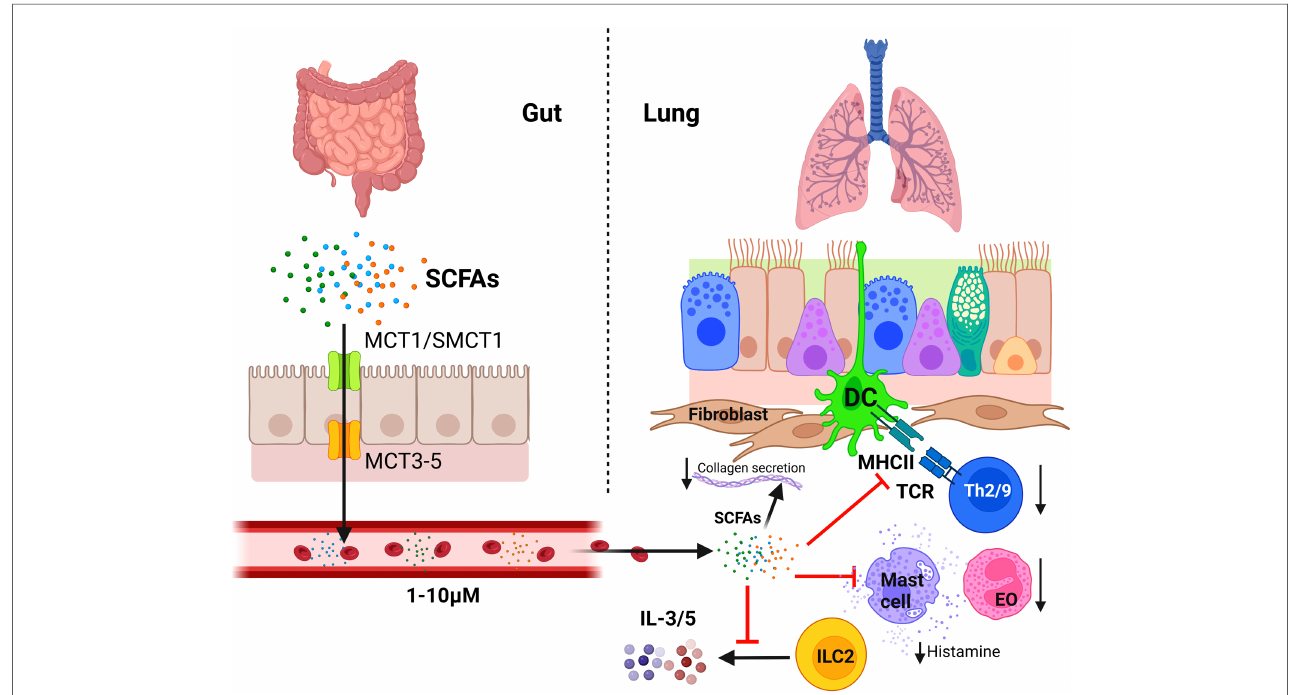
FIGURE 4 Regulatory in fl uence of the gastrointestinal microbiota on the immunology of the lung: the gut-lung axis. Butyrate, propionate, and acetate produced by gut microbiota cross the intestinal epithelial barrier through monocarboxylate transporters and reach distant organs through the bloodstream and the lymphatic circulatory system. In the lung, SCFAs affect the bronchial-associated lymphoid tissue acting as ef fi cient suppressors of the allergic immune reaction. Among other effects, they induce an inhibition of Th2 cell activation and induce T reg cell differentiation, inhibit IL-3 and IL-5 secretion by ILC2 cells and the migration of eosinophils (EO) to airways, induces eosinophils apoptosis, and inhibits mast cell degranulation. In addition, SCFAs can also reduce allergic bronchoconstriction and pulmonary fi brosis by inducing a down-regulation of collagen synthesis by lung fi broblasts (Created with